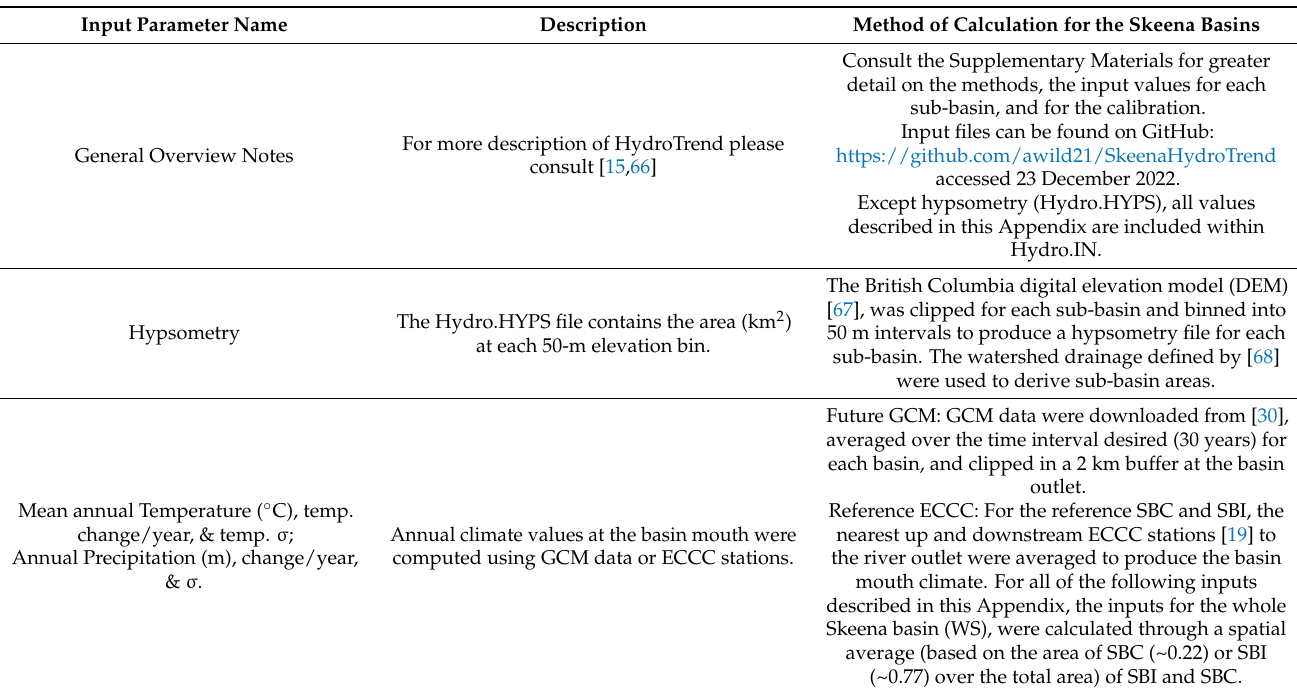
Table A1. HydroTrend Model Input